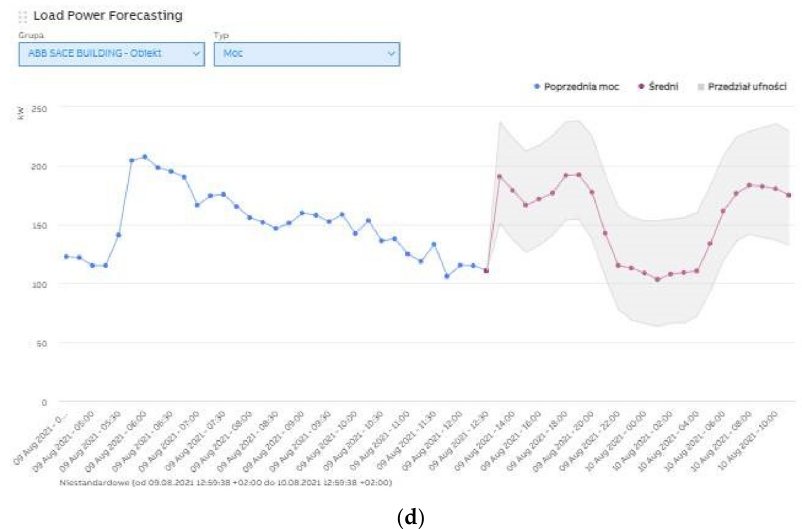
Figure 15. Visualization of the switchgear under constant online supervision. ( a ) Power consumption; ( b ) Asset energy trend; ( c ) Energy cost comparison; ( d ) Load power forecasting.